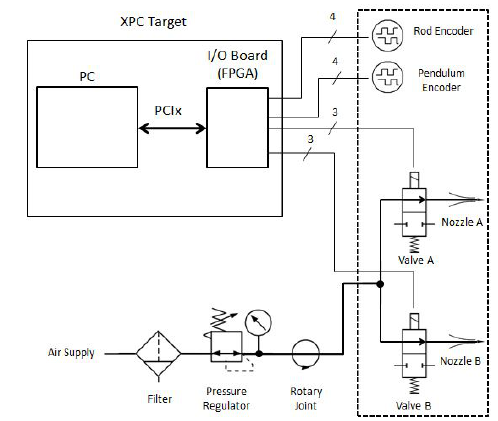
Figure 8. General block diagram of the test setup.